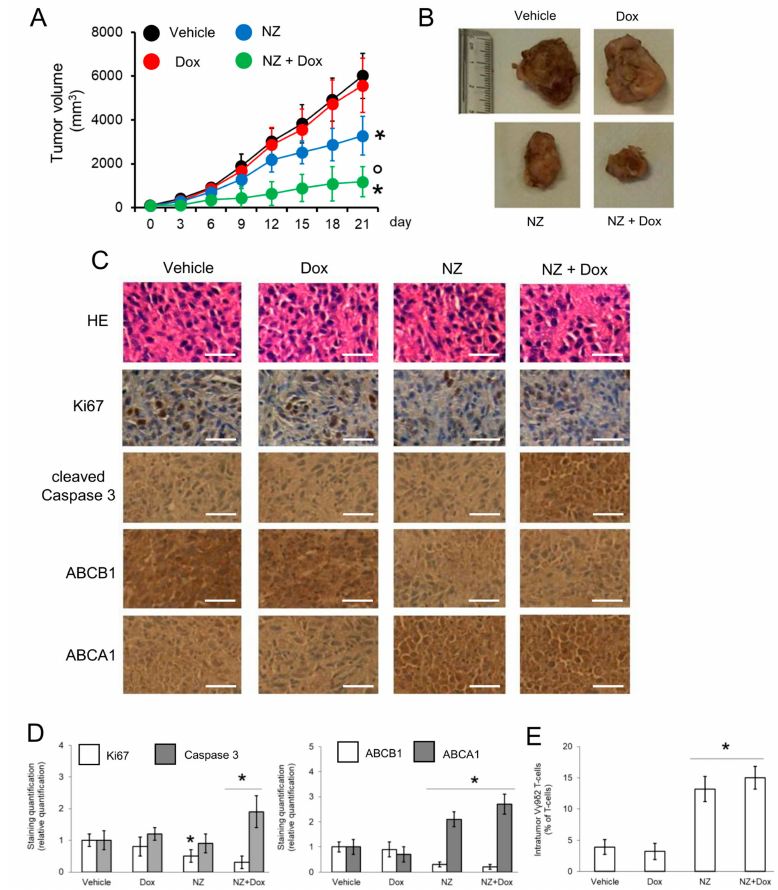
Figure 5. Self-assembled nanoparticles encapsulating zoledronic acid restores chemo-immune-sensitivity in vivo. U-2OS 3D cells (1 × 10 6 ) were injected subcutaneously in Hu-CD34 +